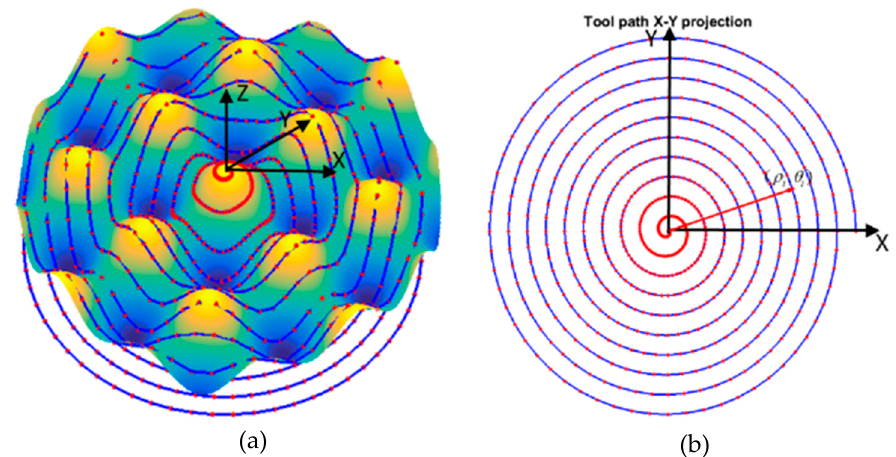
Figure 3. ( a ) STS ideal tool path and ( b ) X–Y projection.